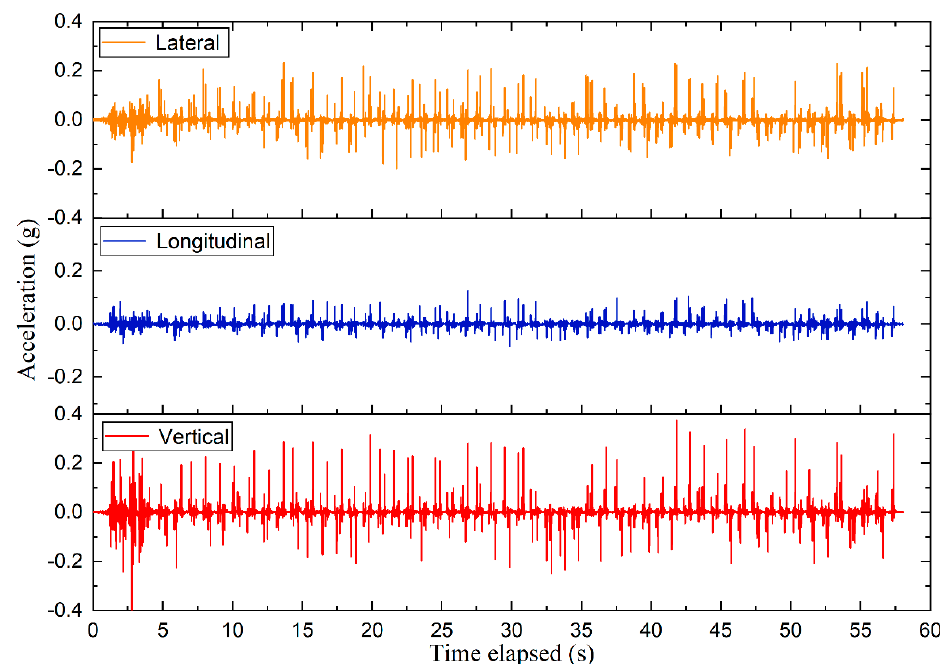
Figure 8. The time-history curves of 3D acceleration responses recorded by #R2 in the ballast bed and normalized for zero initial values.